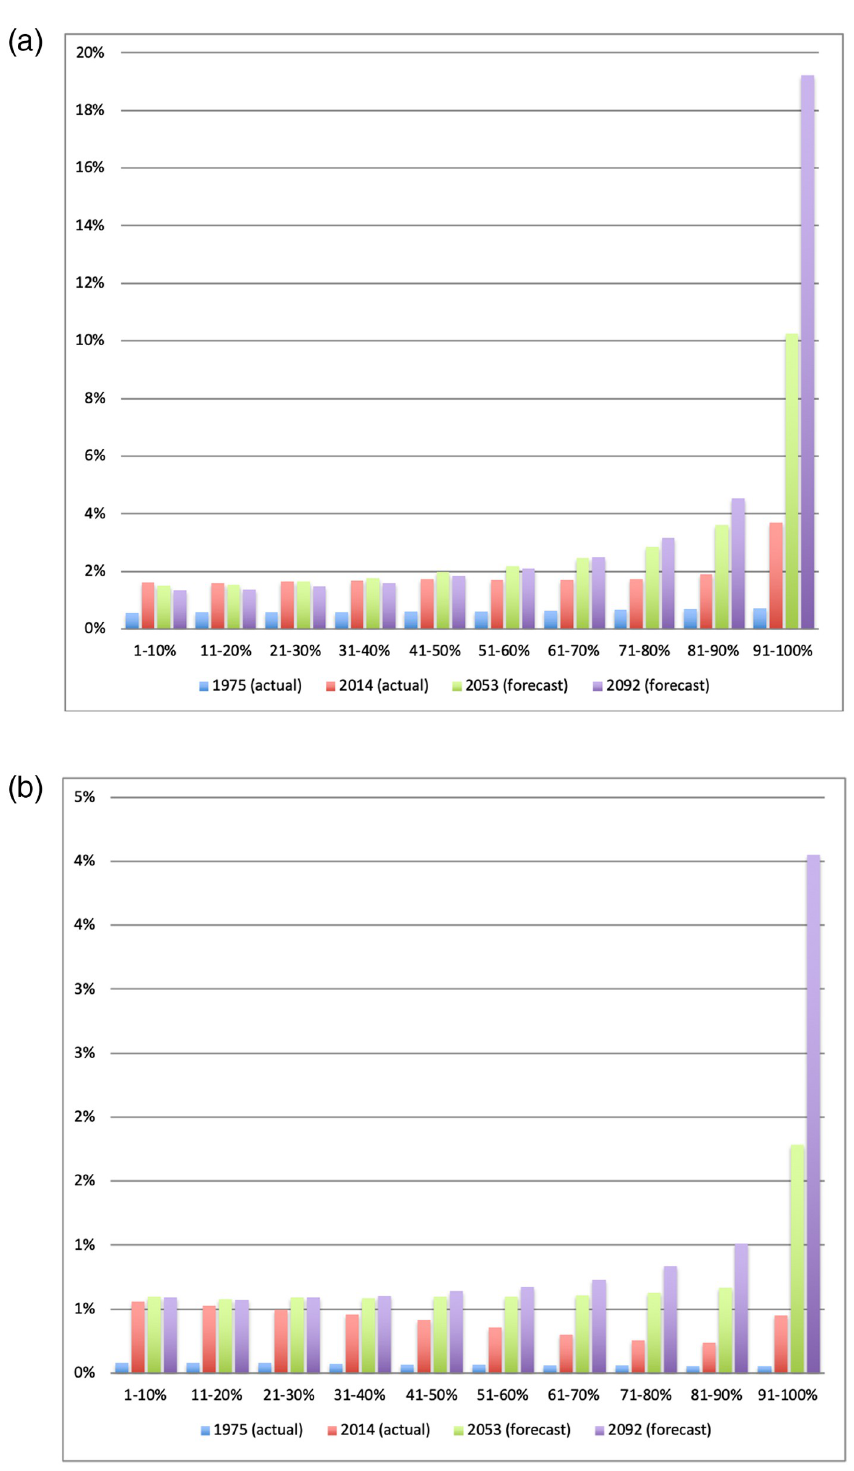
Fig 5. The Figures show a stacked histogram of the frequency distribution of built-up proportions divided into 1975 deciles. In Fig 5a only those cells with a road in 1976 are used in the histograms. Fig 5b does the same thing for cells without a road in 1976. In both Figures, fully built cells are included in the top decile. Since an overwhelming proportion of cells are unbuilt in all years, they are omitted from the Figures for the sake of clarity. The 1975 and